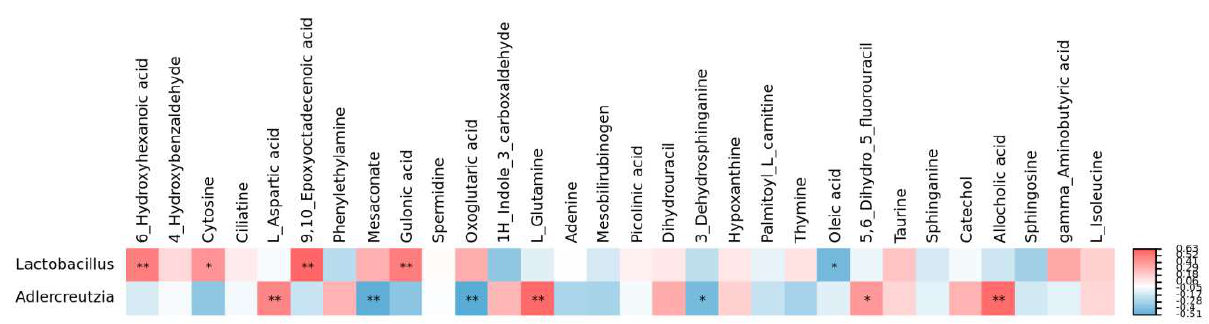
Figure 7. Different pathways analyses are shown as follows: ( A ) NCG vs. FG; ( B ) HBG vs. FG; ( C )